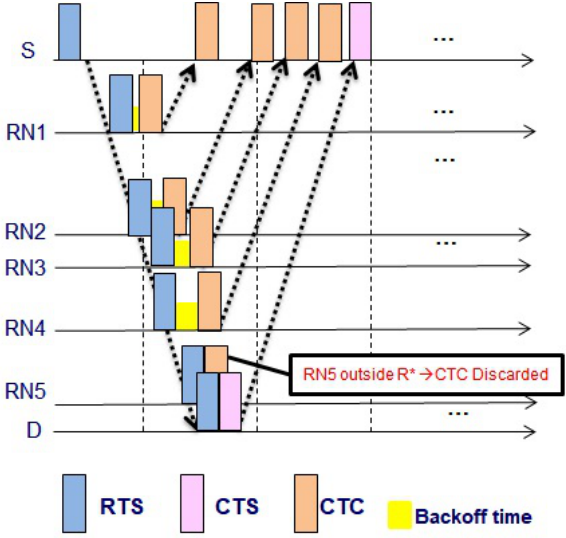
Figure 3. Avoid CTC-CTC